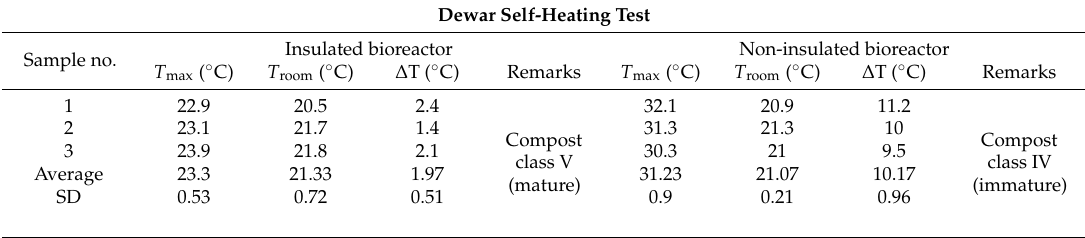
Dewar Self-Heating Test